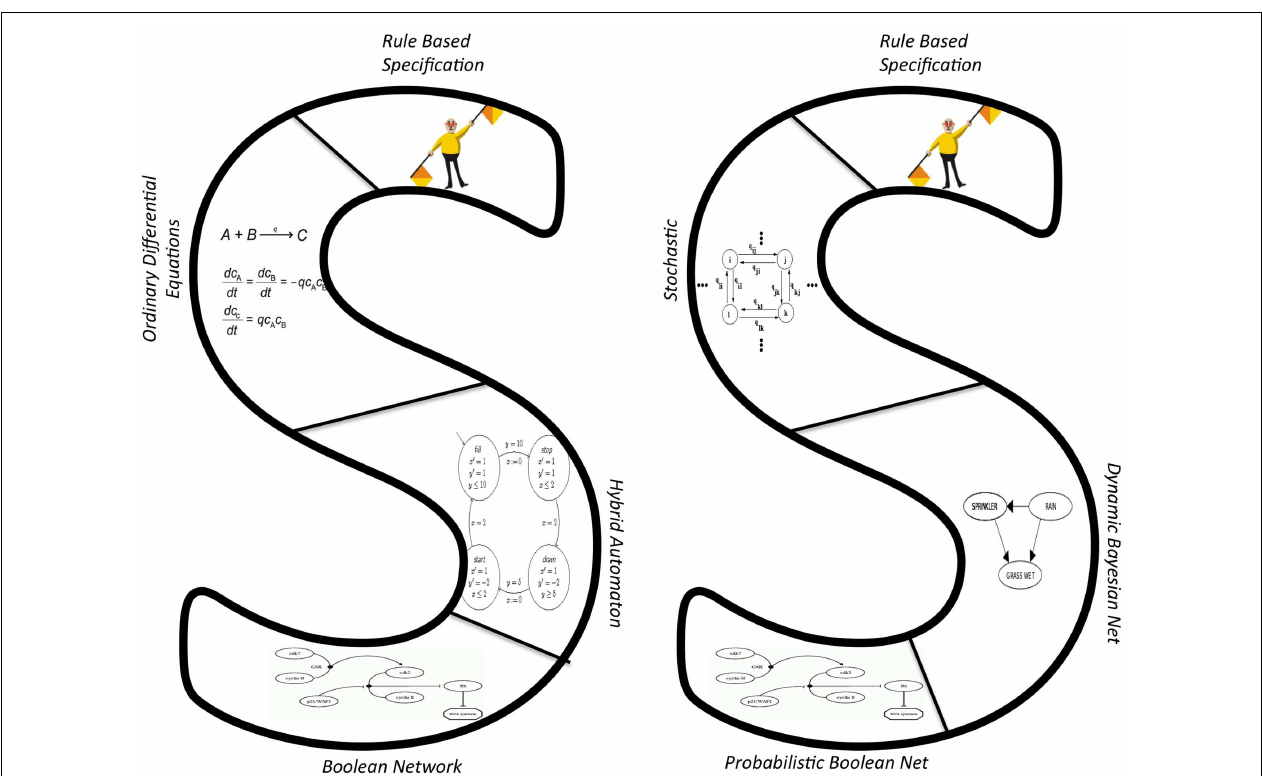
FIGURE 5 | Sequences of abstractions from rule-based specifications to deterministic (right) and stochastic (left) models .